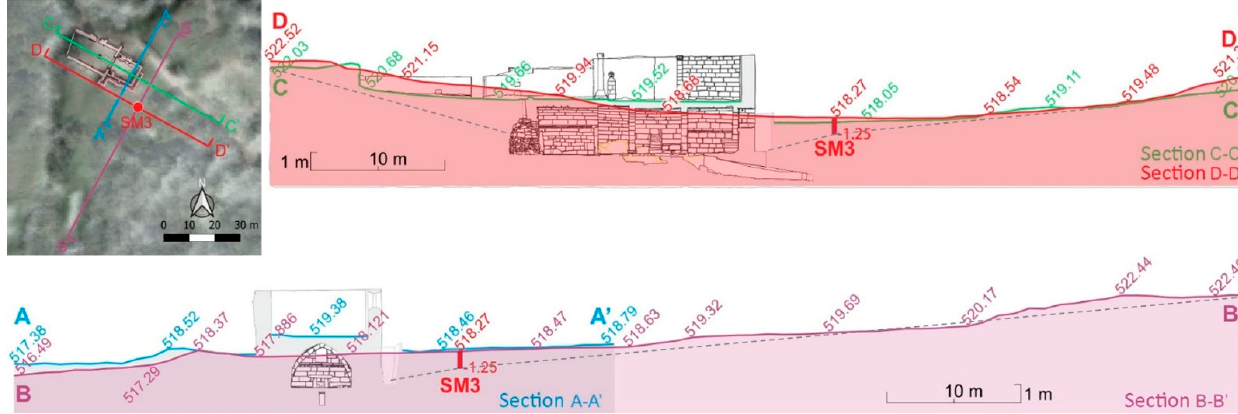
Figure 2. Topographic cross sections showing the position and depth of the core, and the current soil surface, of the Basilica and the Forno. The dashed lines show a hypothetical land surface previous to the modifications of topography at the site.